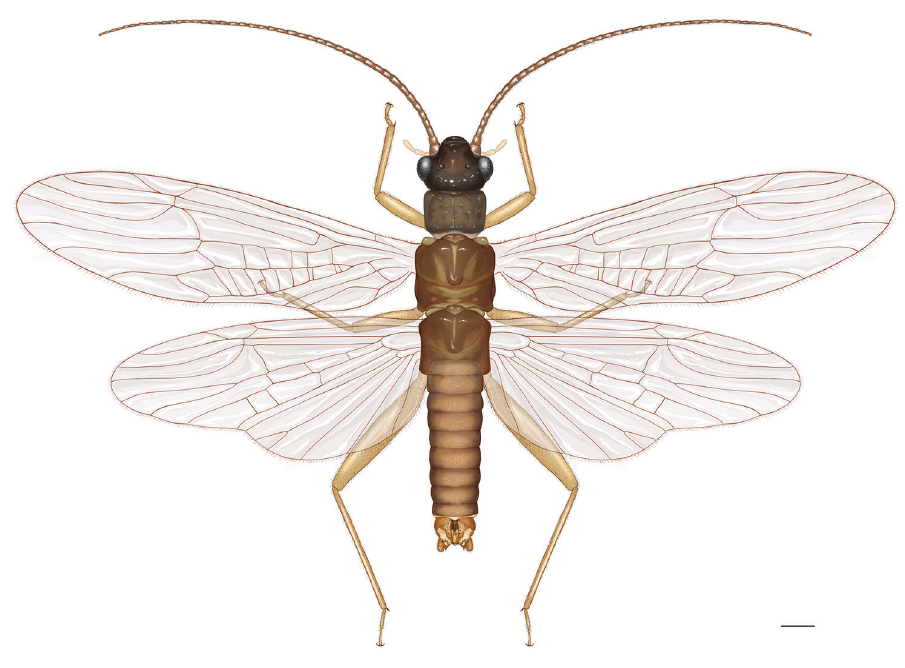
Figure 1. Amphinemura albicauda sp. n., habitus of male holotype adult. Scale bar: 0.5 mm. and armed with large apical teeth, median lobe apically bilobed. Female: subgenital plate subquadrate and slightly lobed, inner sclerite with ear-shaped lobes. Larva: gener- al color brown but cerci contrasting white and hairy, legs with distinct swimming hairs. Description. Adult habitus (Fig. 1): General color light brown to brown. Head and antennae brown, palpi light brown. Thorax brownish, pronotum with distinct rugosities. Legs light brown. Wing membranes grayish, veins brown. Abdomen brown with darker